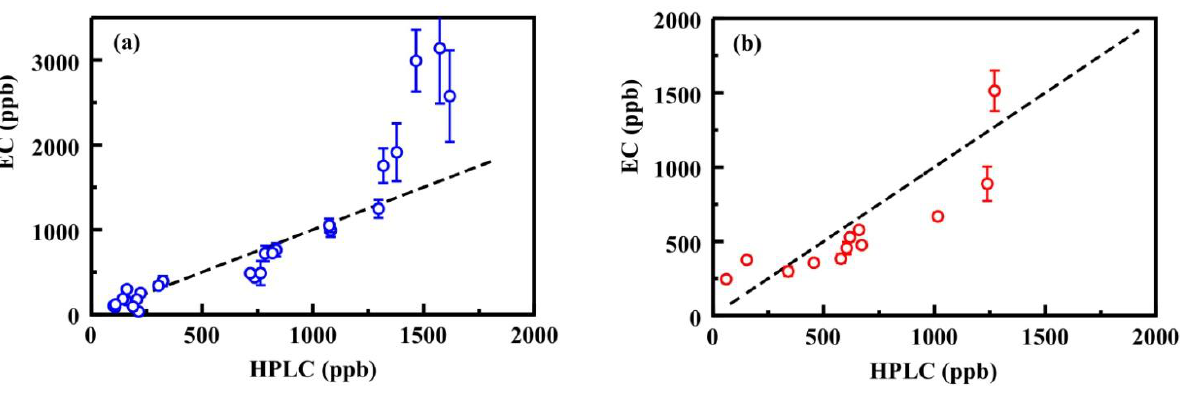
Figure 3. Preconcentration from Milli-Q water. Points here represent the results for quantification of samples using the prototype system with analysis by HPLC (x-axis) and EC (y-axis): ( a ) TNT (−0.62 V ±0.02) and ( b ) DNT (−0.77 ± 0.02). EC results presented use the peak height analysis. The line indicates the expected results based on